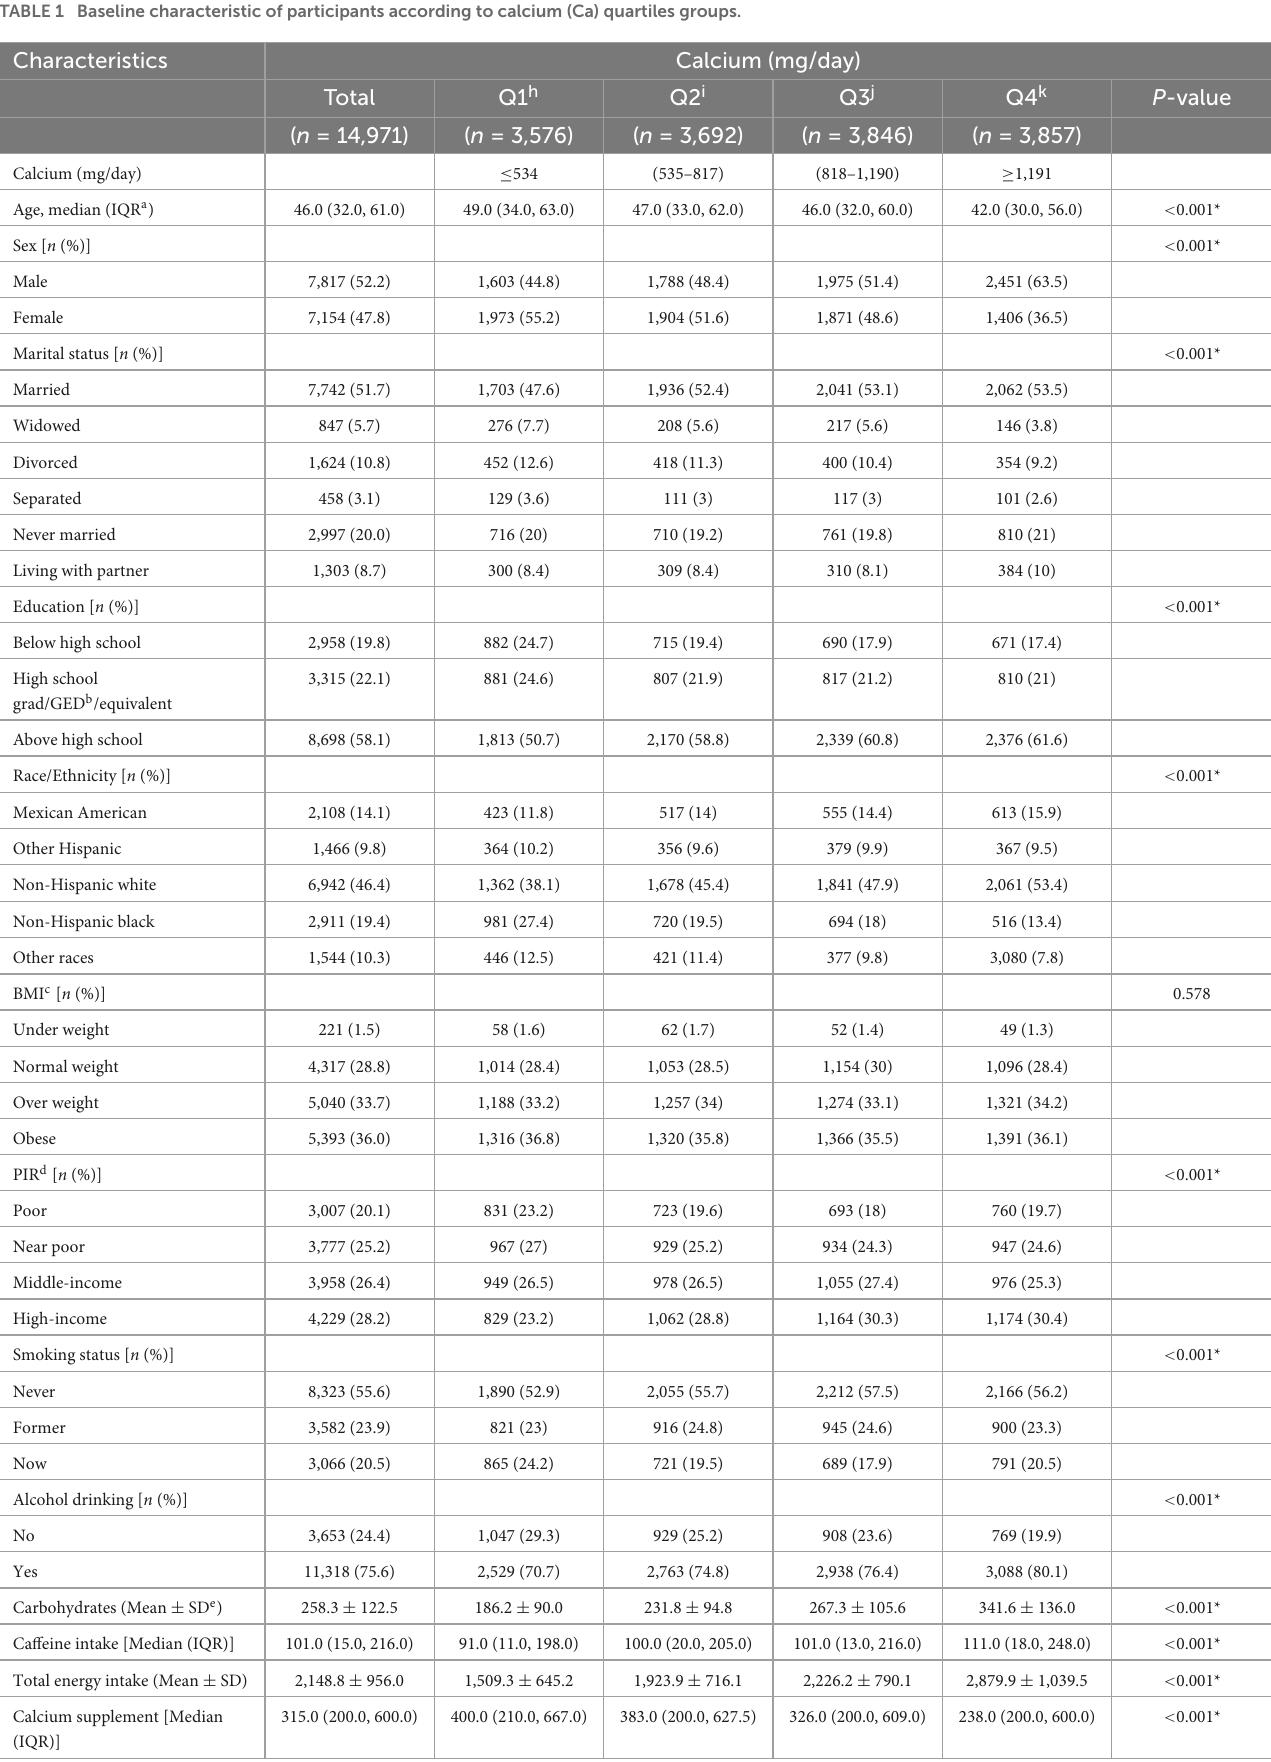
TABLE 1 Baseline characteristic of participants according to calcium (Ca) quartiles groups.